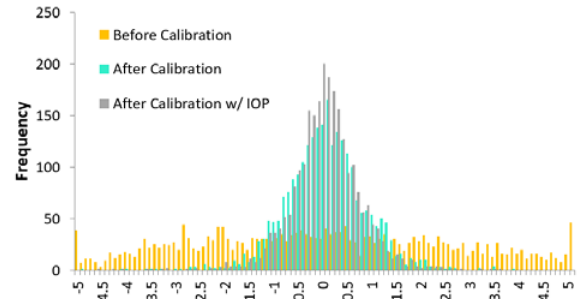
Figure 3: Histogram of the x-image residuals in fluoroscopic system